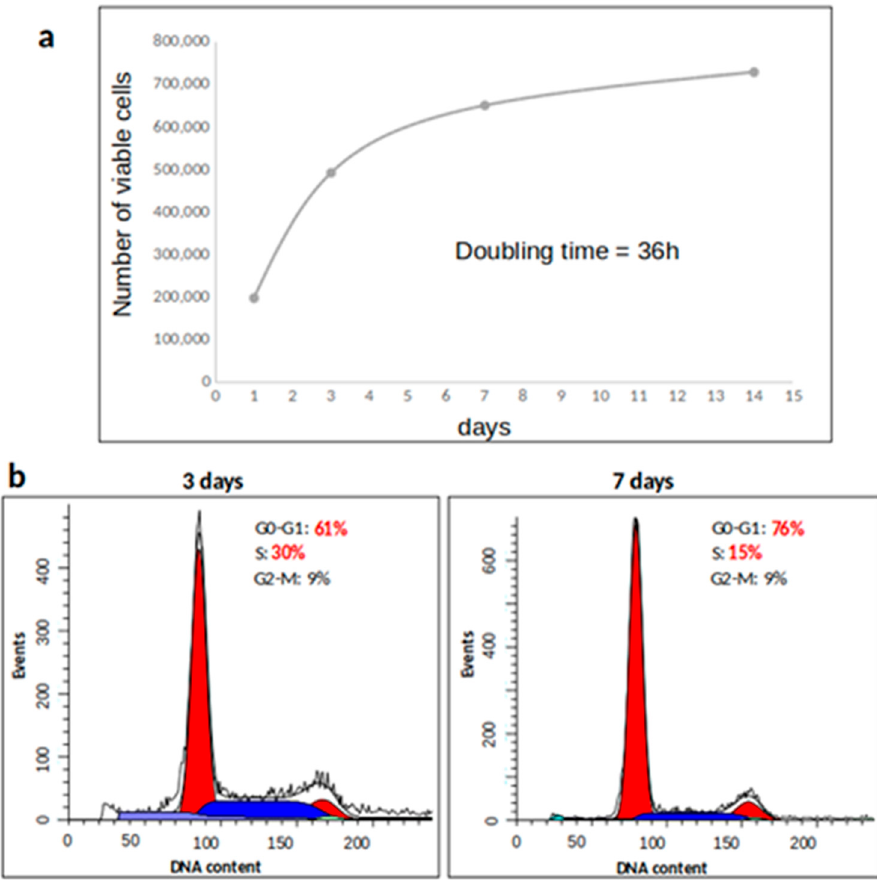
Figure 1. Assessment of 3D cell culture conditions. ( a ) cell growth curve; ( b ) cell cycle analysis. The figure depicts the results obtained in one experiment representative of three.